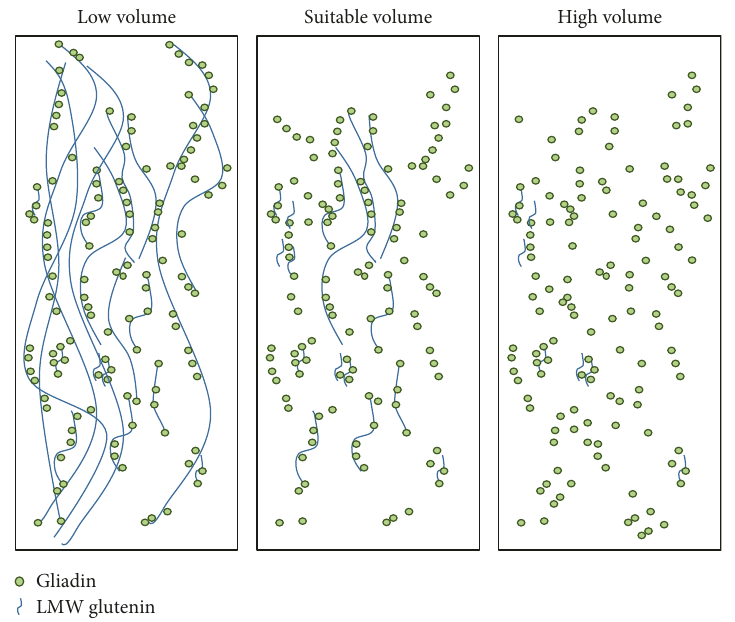
Figure 1: Gliadin and glutenin behavior in di ff erent volume of ethanol 70% ( v/v ).